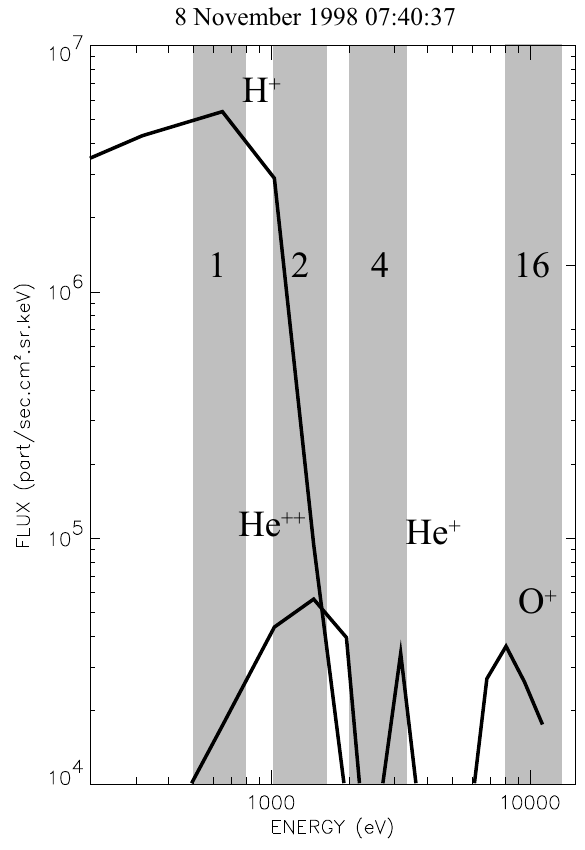
Fig. 4. Average energy spectra for the H + , He ++ , He + and O + precipitated ions observed around 07:40:37 UT on board Interball Auroral. The vertical gray areas indicate the energy ranges which correspond to an energy/charge ratio equal to the mass ratio, based on the hydrogen energy